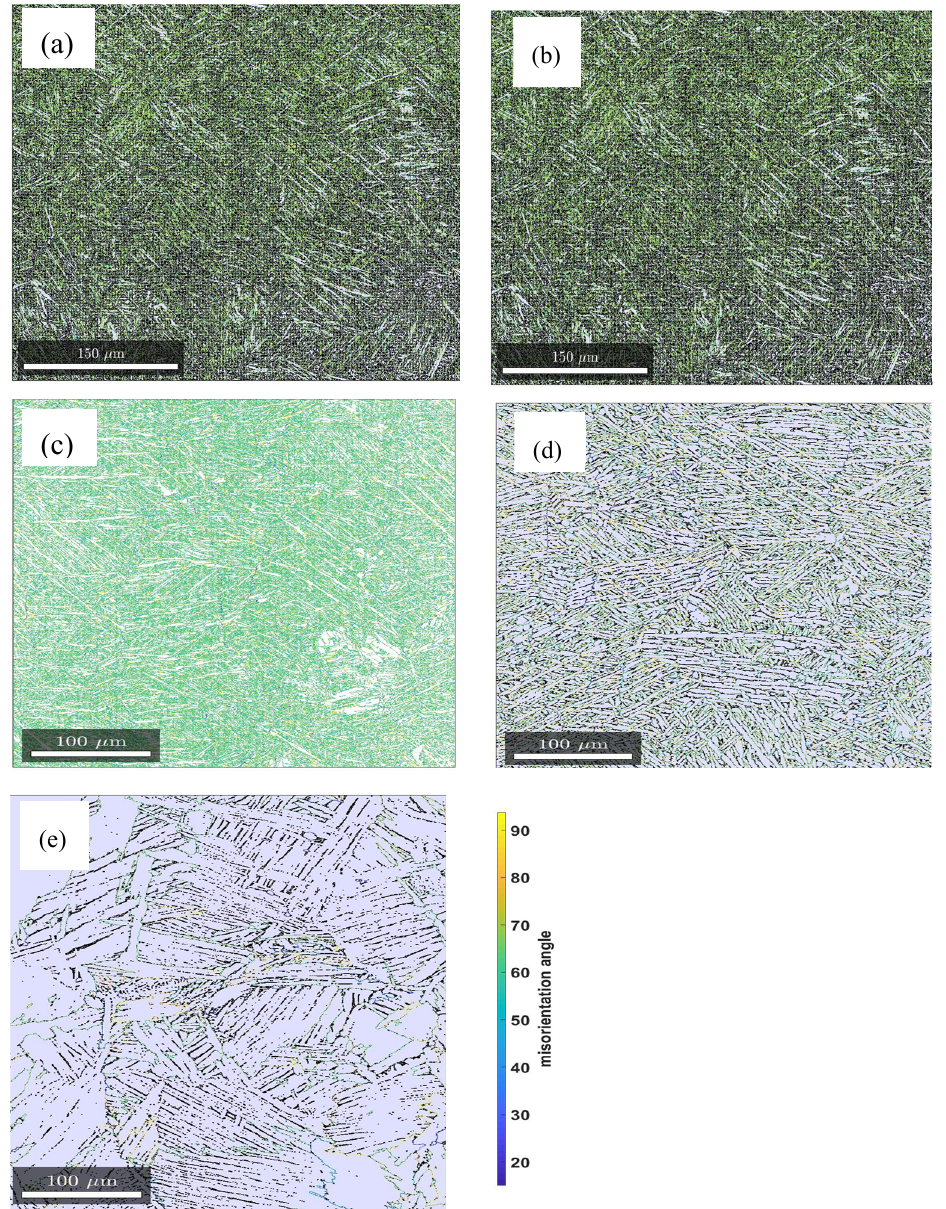
Figure 4. Grain boundary misorientation angles of the samples ( a ) A, ( b ) B, ( c ) C, ( d ) D and ( e ) E.